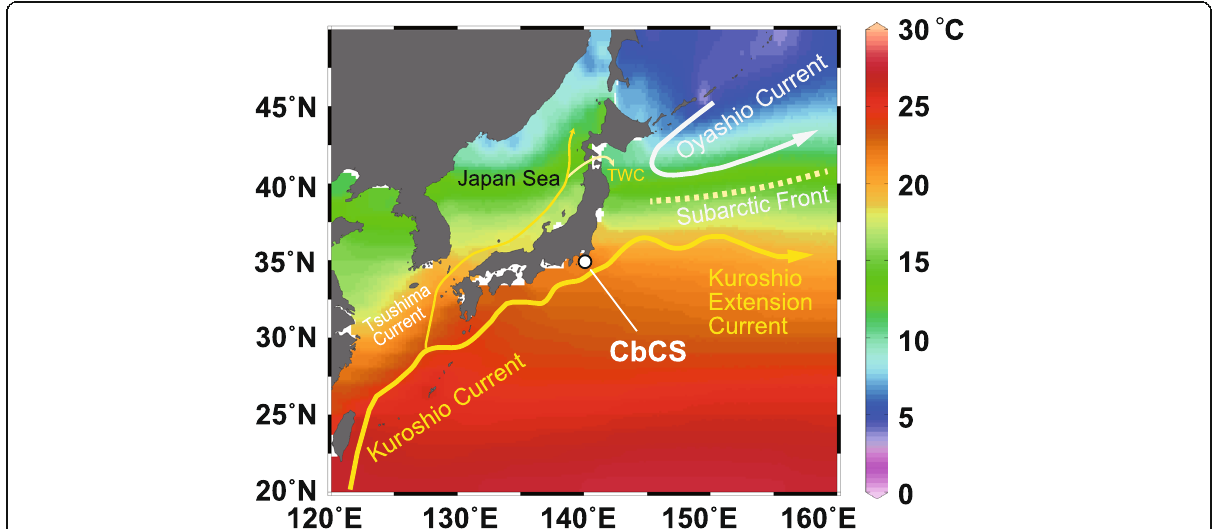
Fig. 1 Oceanographic circulation in summer around Japan. The CbCS (white circle) is located in the middle of the Boso Peninsula, central Japan. Positions of major ocean currents are based on Brown et al. (2001). Ocean temperature gradients are from World Ocean Atlas 2013 (Locarnini et al. 2013), which was drawn using Ocean Data View software (Schlitzer 2015). This figure was redrawn after Suganuma et al.